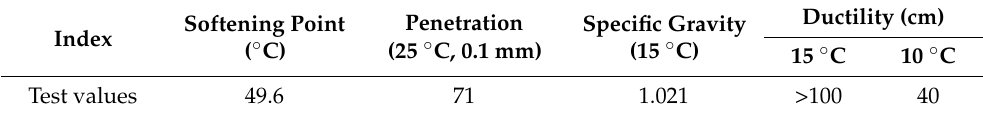
Table 4. Properties of the Pen 70 asphalt